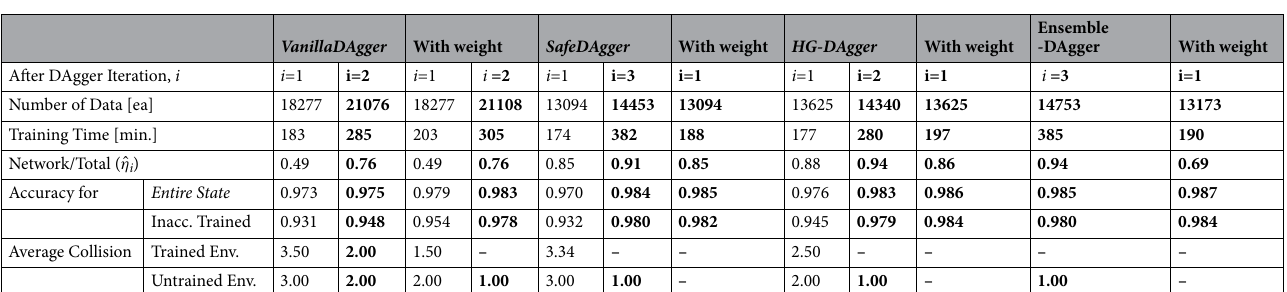
Table 4. Driving Test Results for DAgger variant algorithms and with Weighted loss function (proposed) * Note . “with weight” means the DAgger with the weighted loss function (proposed). In this test, ε and α were set to 70% and 10. In “Training Time”, data collection time and training time were included, when GeForce RTX 2080 TI GPU was used to train the policy. Significant values are in bold.